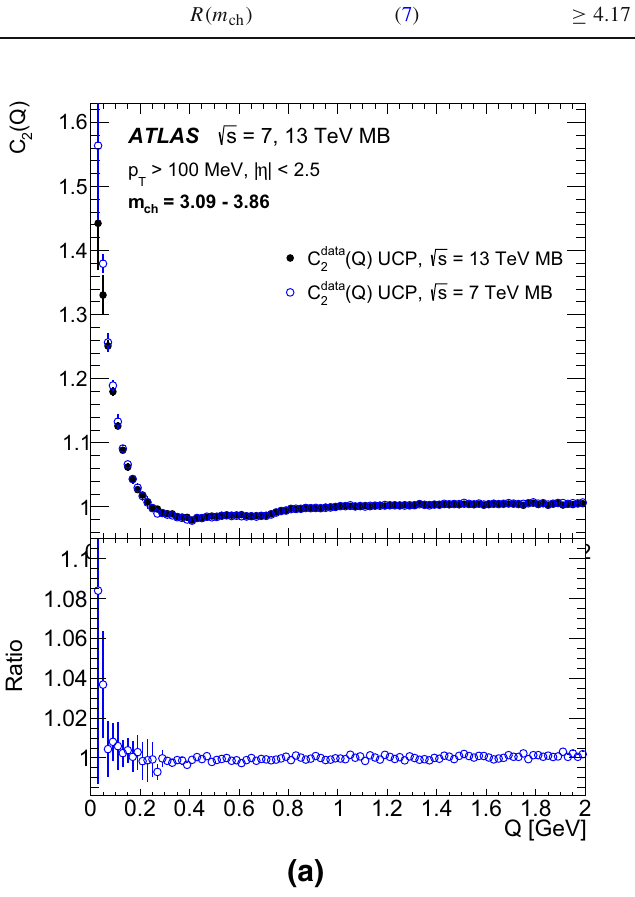
Fig. 5 Comparison of single-ratio two-particle correlation functions, tative multiplicity region 3 . 09 < m ch ≤ 3 . 86 and b for representative k T region 400 < k T ≤ 500 MeV. The statistical and systematic uncer- using the unlike-charge particle (UCP) pair reference sample, for ( Q ) (top panel) at 13 TeV minimum-bias (MB) events, showing C data tainties, combined in quadrature, are presented. The systematic uncer- 2 ( Q ) tainties include track efficiency, Coulomb correction, non-closure and (black circles) and 7 TeV (open blue circles), and the ratio of C 7 TeV 2 multiplicity-unfolding ( Q ) (bottom panel). Comparison of C data ( Q ) a for represen- to C 13 TeV 2 2